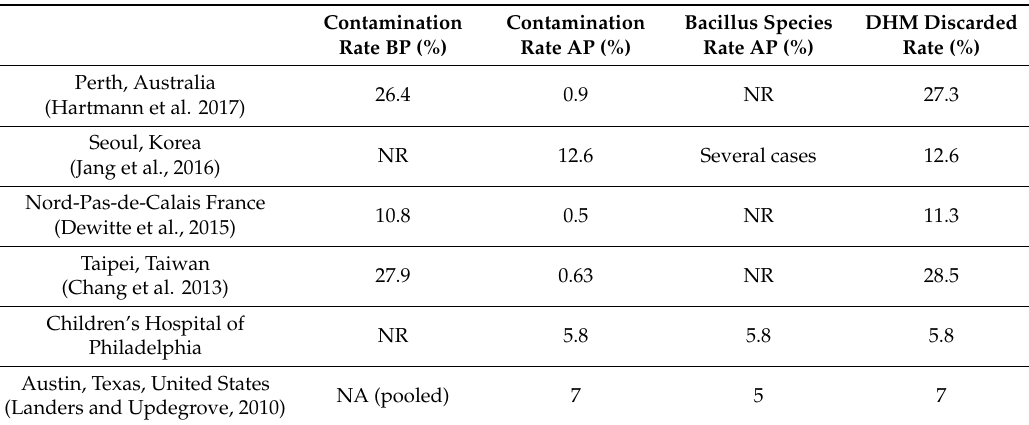
Table 1. Practice and rate of contamination of donor human